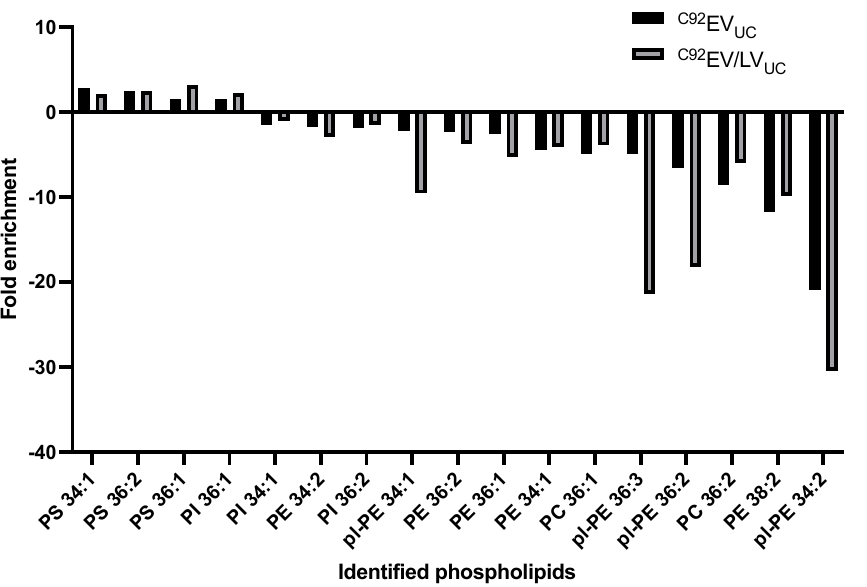
Figure 10. Phospholipids identified in Clone 92 EVs and LVs compared to Clone 92 parent cells. PS: phosphatidylserine, PI: phosphatidylinositol, PE: phosphatidylethanolamine, pl-PE: plasmalogen-phosphatidylethanolamine PC: phosphatidylcholine. Error bars indicate SEM.